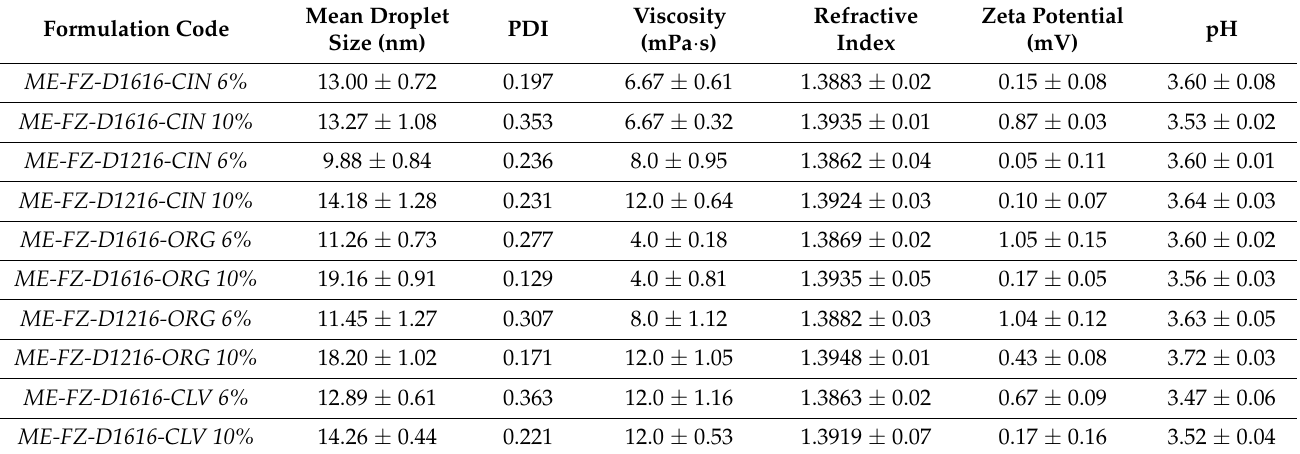
Table 7. Mean droplet size, polydispersity index (PDI), viscosity, refractive index, zeta potential and pH of the experimental fluconazole-loaded biocompatible